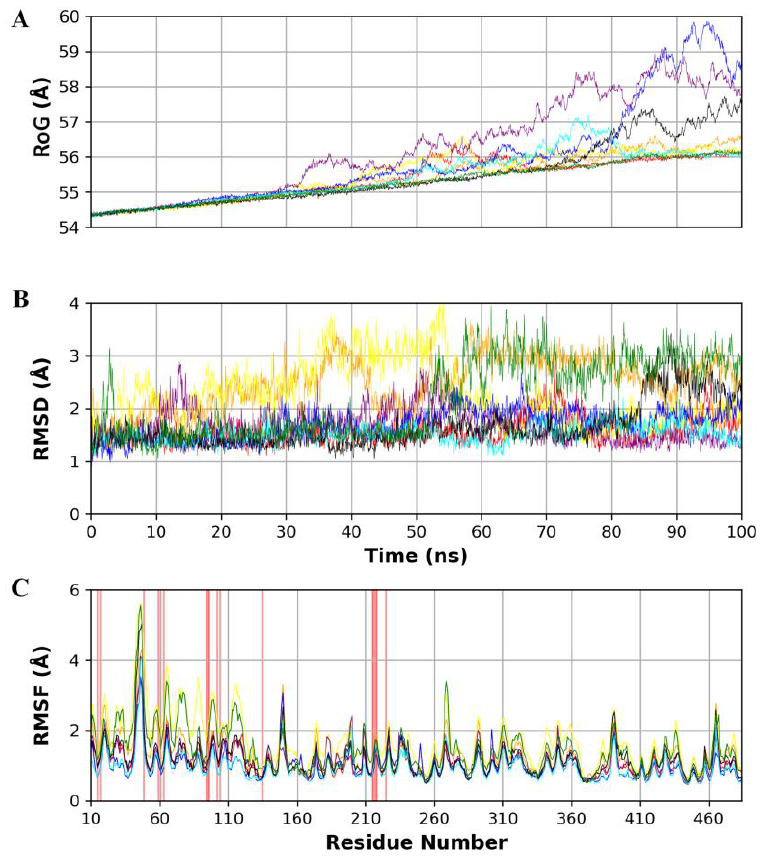
Figure 6. ( A ) Radius of gyration (RoG) of the protein throughout the simulation time. ( B ) Root mean square deviation (RMSD) of the protein alpha carbons throughout the simulation. ( C ) Per residue root mean square fluctuation (RMSF) with the amino acid residues of the binding site are presented with a red background. The color scheme is represented as the following: (red: Remdesivir, orange: Lapatinib, yellow: Fexofenadine, purple: NANPDB1, blue: NANPDB2, cyan: NANPDB3, black: Holoprotein, and green: unliganded protein).